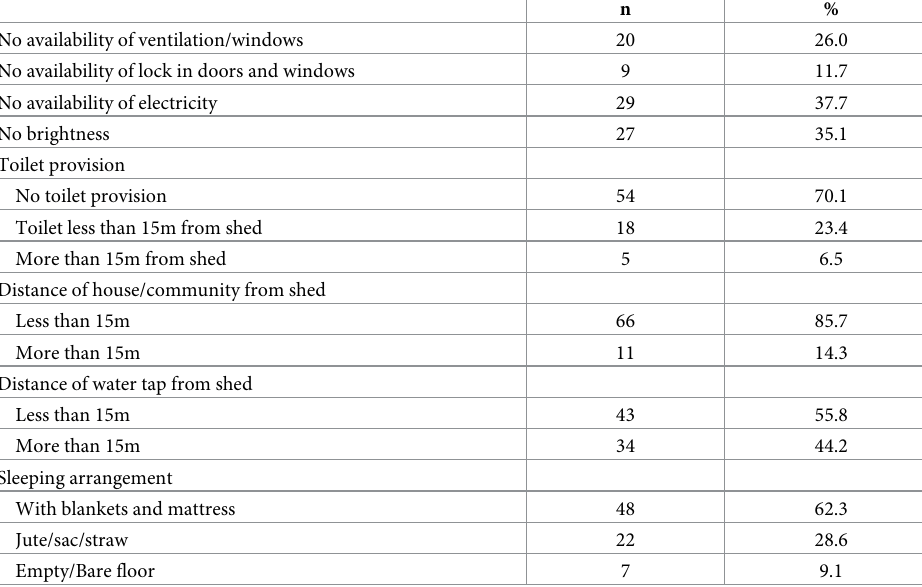
Table 4. Findings from observation of menstrual exile living spaces (N =